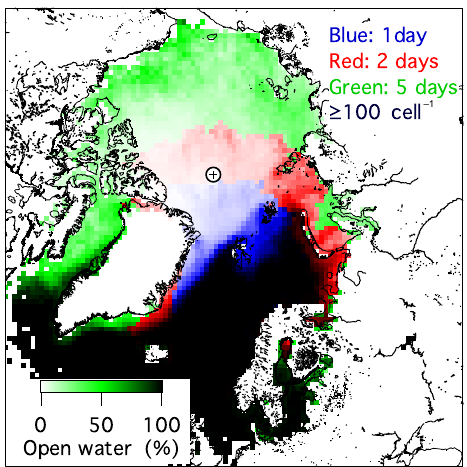
Figure 2. Map of the regional distribution of open water under 87648 5-day (green), 2-day (red), and 1-day (blue) hourly back trajectories to Mt. Zeppelin during the during the months March through October of the years 2006–2015. Black cross in a circle: North Pole. The areas are covered with at least 100 trajectory hours concurrent with data values per geocell.